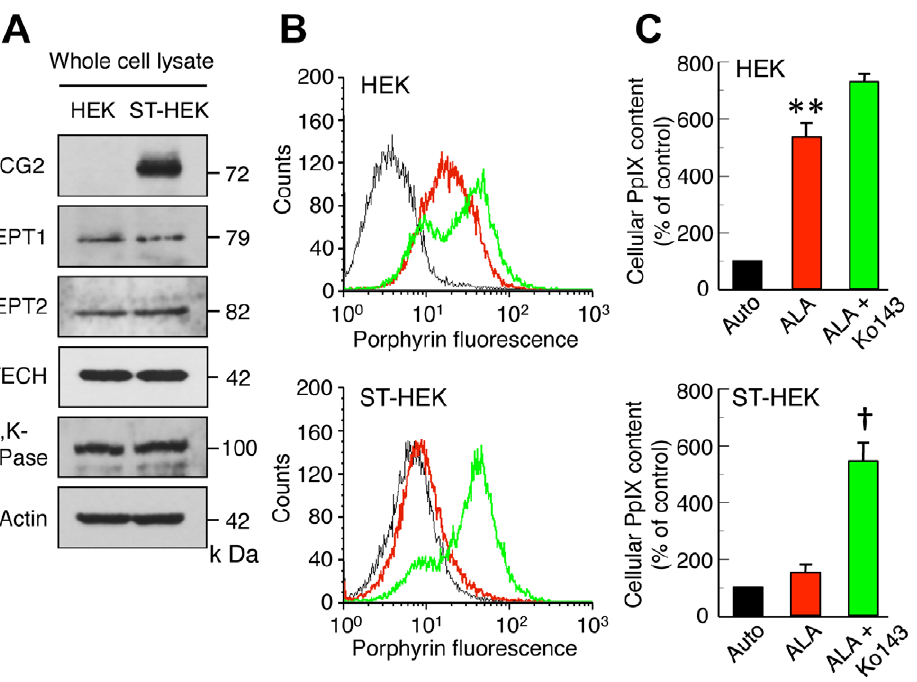
Figure 5. ABCG2-dependent regulation of ALA-mediated PpIX accumulation. A , Western blot analysis of whole cell lysates of HEK cells and ST-HEK cells. A representative blot of multiple experiments is shown. Na, K-ATPase and actin were used as a plasma membrane marker and loading control, respectively. B , Flow cytometric histograms of intracellular ALA-mediated PpIX contents in HEK cells and ST-HEK cells. The porphyrin autofluorescence (black line) in HEK cells and ST-HEK cells was measured. Cells were incubated with 1 mM ALA in complete medium for 3 h in the presence ( green line ) or absence ( red line ) of Ko134, and then cellular contents of PpIX were measured using a flow cytometer. C, Bar graphs show the flow cytometric analysis of the cellular PpIX contents. Mean intensities of fluorescence (autofluorescence values) obtained from control experiments of each cell line were normalized to 100%. Results represent the mean 6 SD of three independent experiments. ** P , 0.01 vs. auto. { P , 0.01 vs. ALA-